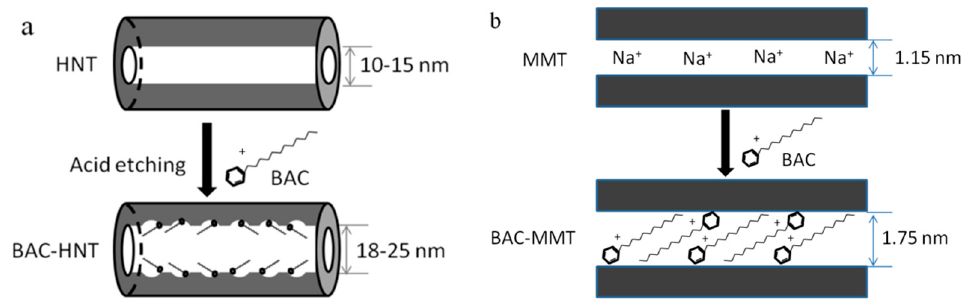
Figure 1. The schematics of ( a ) halloysite nanotubes (HNT) and ( b ) montmorillonite (MMT) loading benzyl ammonium chloride (BAC).